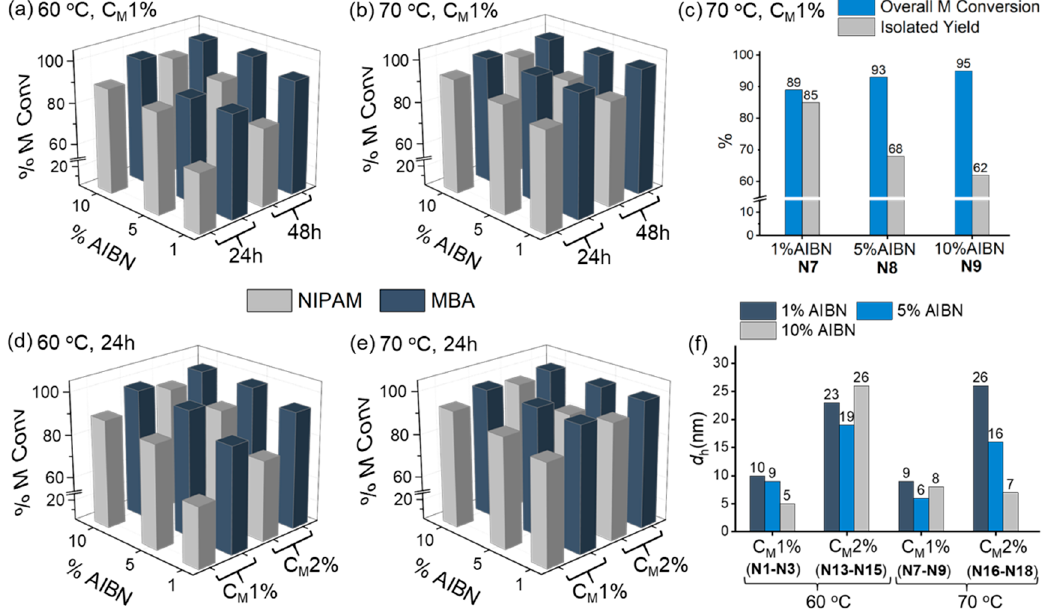
Figure 2. ( a )–( e ) Graphs comparing monomer conversions, calculated by 1 H NMR analyses, for polymerizations of NIPAM (80 mol %) and MBA (20 mol %) carried out under different conditions: ( a ) Nanogels N1 , N2 , and N3 polymerized for 24 h with 1, 5, and 10% AIBN, respectively, and N4 , N5 , and N6 for 48 h with 1, 5, and 10% AIBN, respectively. In all cases C M is 1% and T = 60 ◦ C. ( b ) Nanogels N7 , N8 , and N9 polymerized for 24 h with 1, 5, and 10% AIBN, respectively, and N10 , N11 , and N12 polymerized for 48 h with 1, 5, and 10% AIBN, respectively. In all cases, C M was 1% and T = 70 ◦ C. ( c ) Comparison of overall monomer conversions and isolated yield measured for nanogels N7–N9 . ( d ) Nanogels N1 , N2 , and N3 polymerized with 1, 5, and 10% AIBN, respectively, and C M was 1%, and N13 , N14 , and N15 with 1, 5, and 10% AIBN, respectively, and C M was 2% (reaction time = 24 h, T = 60 ◦ C). ( e ) Nanogels N7 , N8 , and N9 polymerized with 1, 5, and 10% AIBN, respectively, and C M 1%, and N16 , N17 , and N18 with 1, 5, and 10% AIBN, respectively, and C M was 2% (reaction time = 24 h, T = 70 ◦ C). ( f ) Graph showing the impact of polymerization temperature, initial concentration of AIBN, and total monomer concentration (C M ) on the particle size determined by DLS measurements for polymerizations of NIPAM (80 mol %) and MBA (20 mol %). Polymerization time is 24 h in all cases. See original raw data in the ESI (Figures S5–S11).